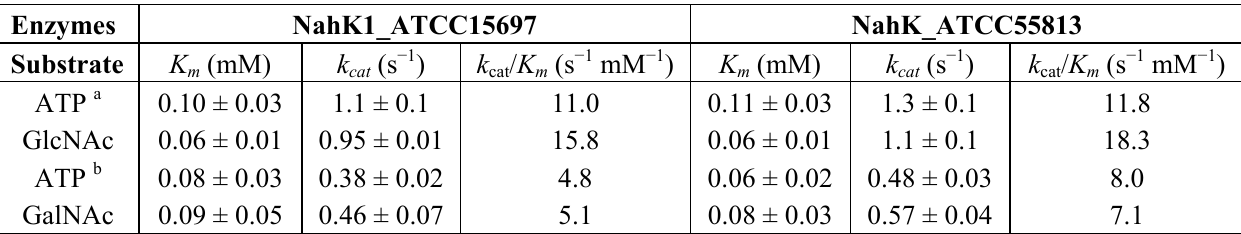
Table 1. Apparent kinetic parameters of